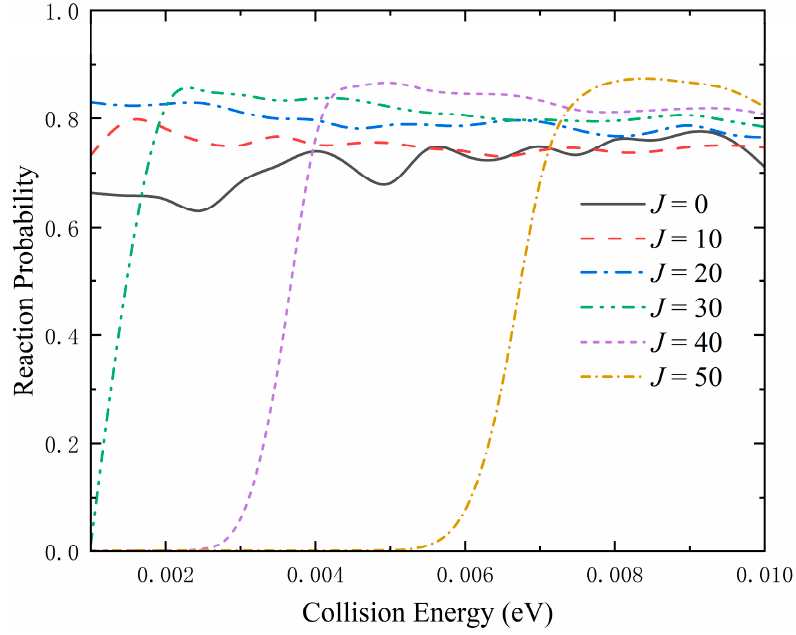
Figure 7. Collision energy dependence of total reaction probabilities with six partial waves ( J = 0, 10, 20, 30, 40 and 50) of the Li( 2 S) + Na 2 ( v = 0, j = 0) → LiNa + Na reaction calculated by the improved TDWP method on the GP PES.